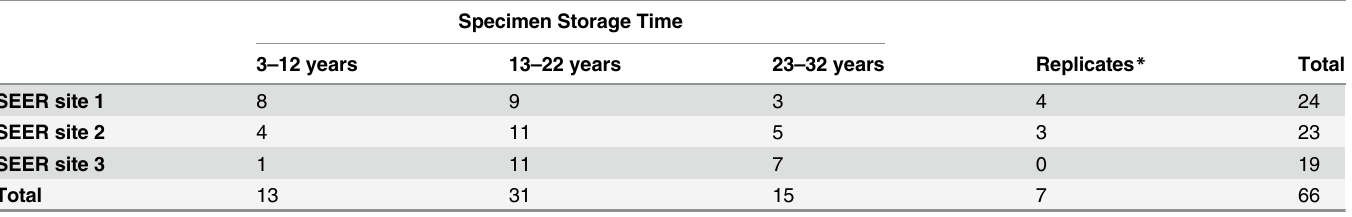
Table 1. FFPE specimens selected for